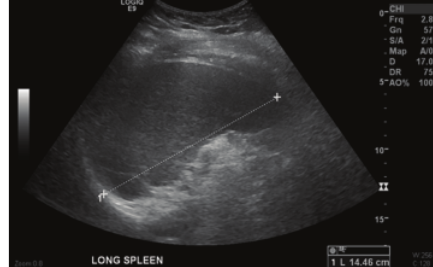
Figure 1: Abdominal ultrasonogram showing the patient’s spleno- megaly.